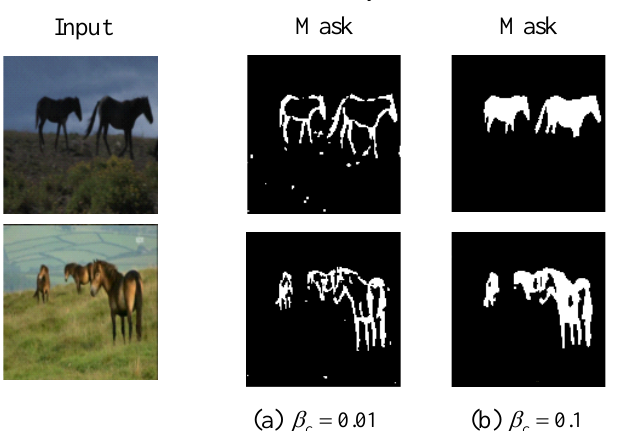
Figure 6. The experimental results of different β c for the closed loss. The suitable β c achieves a smooth mask without concave